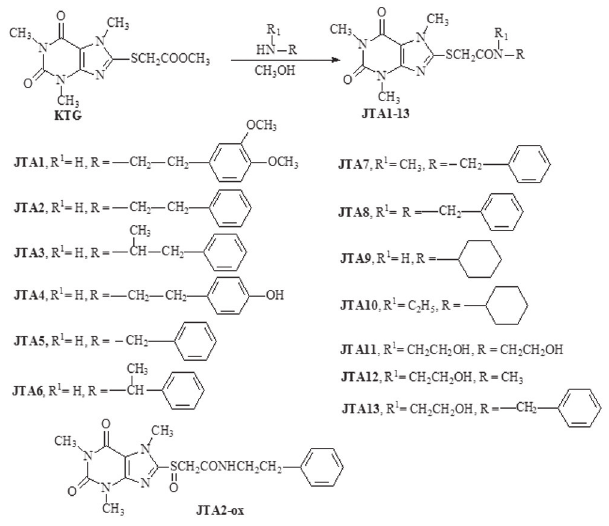
FIGURE 1 - Synthesis of caffeine-8-thioglycolic acid (KTG)